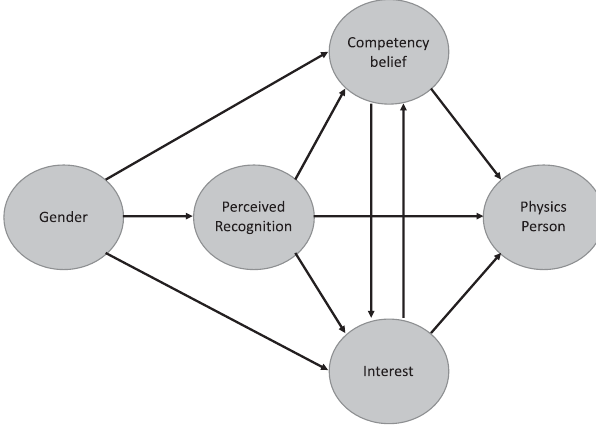
FIG. 1. Schematic representation of the theoretical framework regarding physics